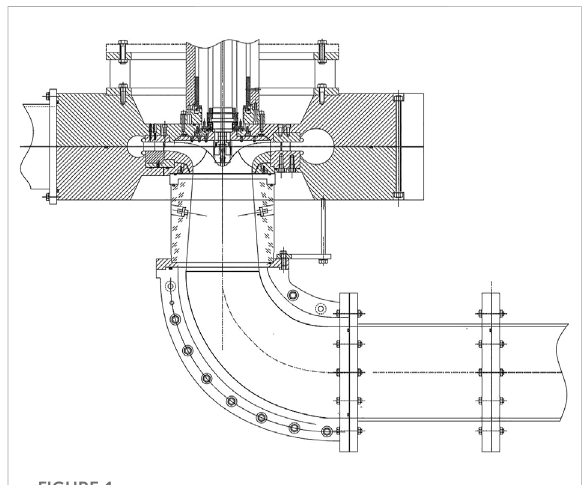
FIGURE 1 Structural drawing of large vaned-voluted centrifugal pump.